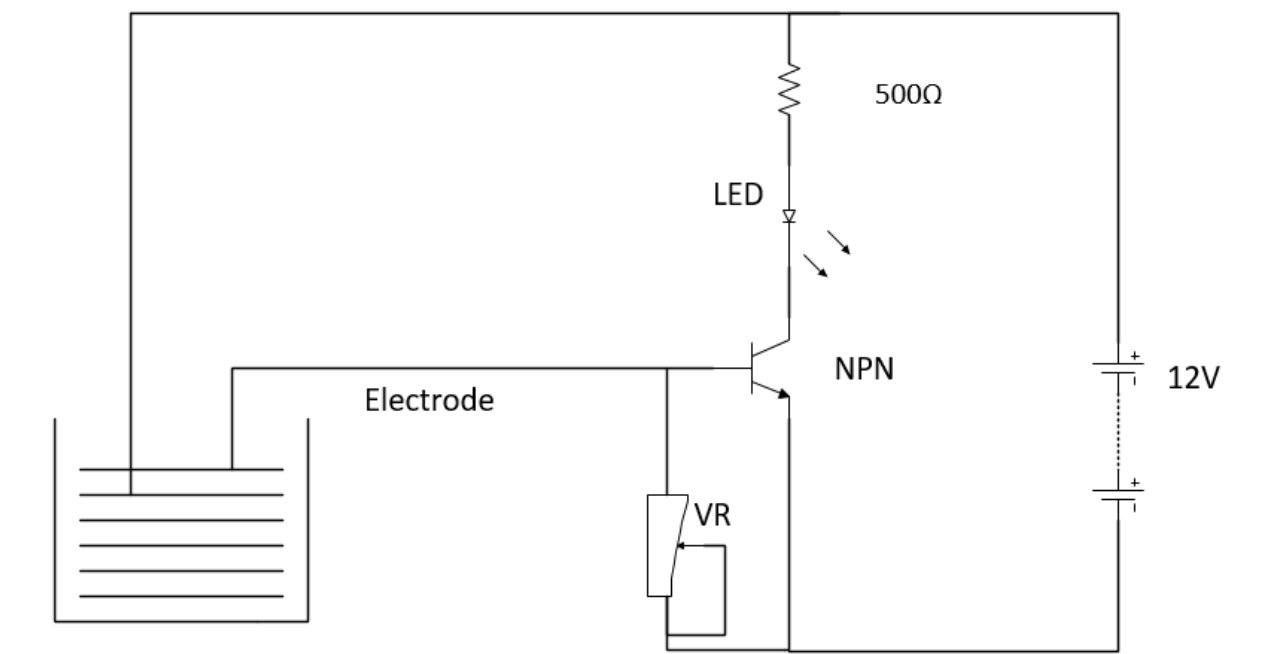
Figure 4. Circuit diagram of water level sensor used in proposed system.